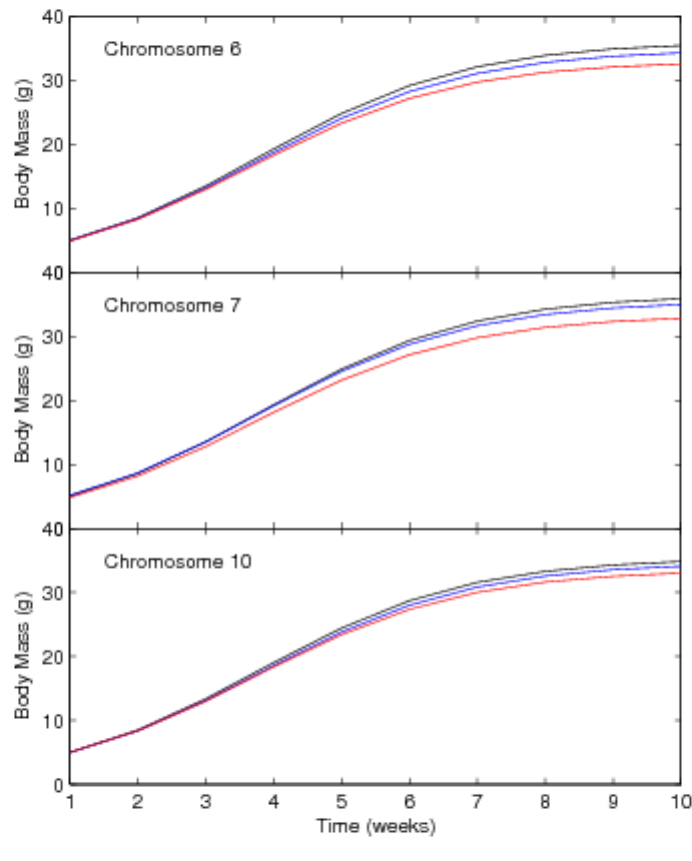
Figure 2. Fitted growth curves for the three QTL genotypes ( qq , red; Qq , blue; QQ , black) assuming a single QTL is located on mouse chromosome 6, 7 and